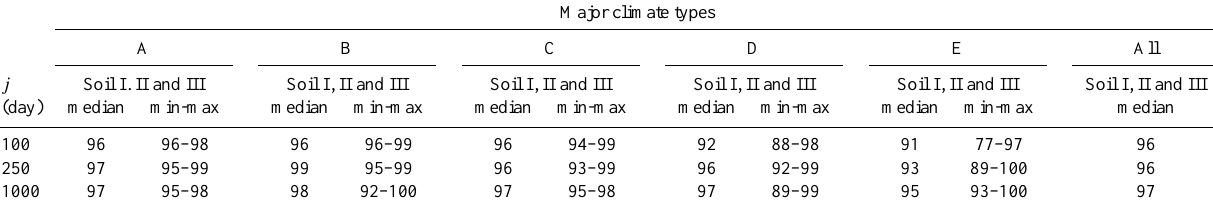
Table 4. Impact of soils on the similarity index (SI) (%) for the five K¨oppen–Geiger major climate types and three groundwater systems. Major climate types A B C D E